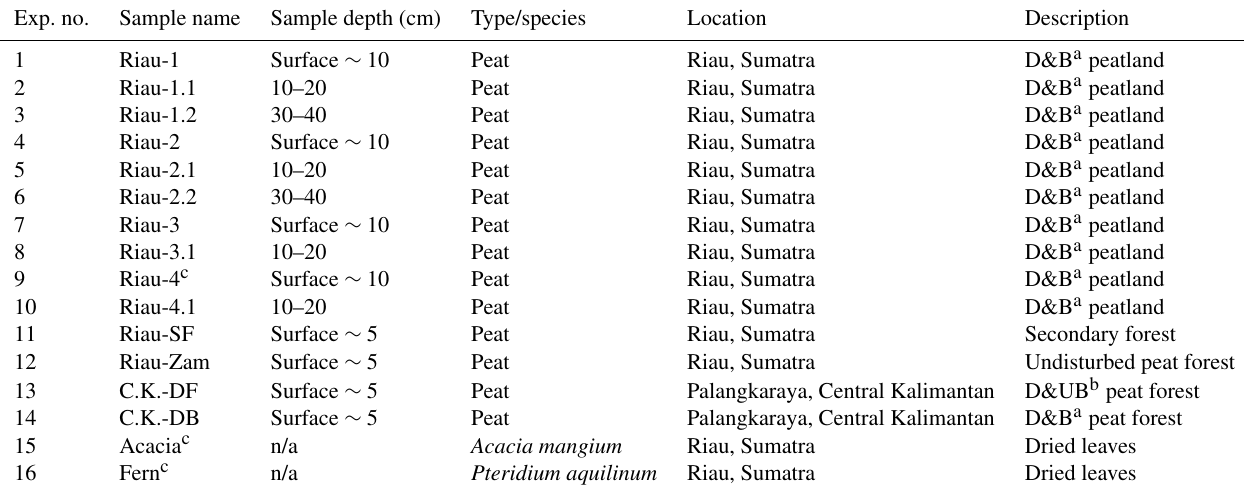
Figure 1. Schematic diagrams of the laboratory experimental setups. (a) The experimental setup for combustion experiment and subsequent online measurements, and (b) experimental setup for offline measurements of water extracts ( A 0 , blue arrows) and 1-octanol–water extracts ( A 1 , magenta arrows) from the filter samples. Table 1. Summary of Indonesian peat and biomasses used for the laboratory combustion experiments. Samples 9, 15, and 16 were also used for offline experiments of their aqueous extracts ( A 0 and A 1 ). Exp.